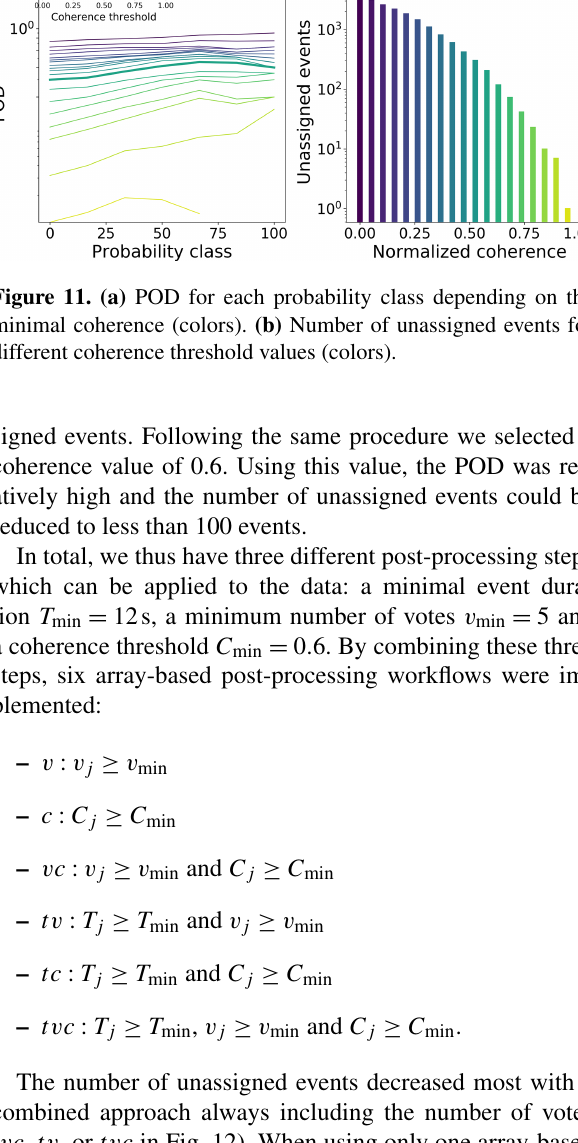
Figure 12. (a) POD for each probability class for different post- processing workflows (colors). v is minimal number of votes used, t is minimal event duration and c is minimal coherence. (b) Number of unassigned events remaining after the post-processing for each workflow.